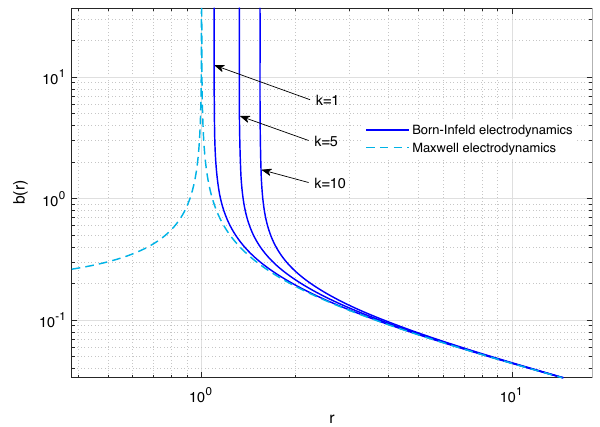
Fig. 4 Normalized magnetic field induction as a function of the radial coordinate r . The solution was obtained for Born–Infeld electrody- namics with the boundary condition (35) at r → ∞ and the constant c 10 =